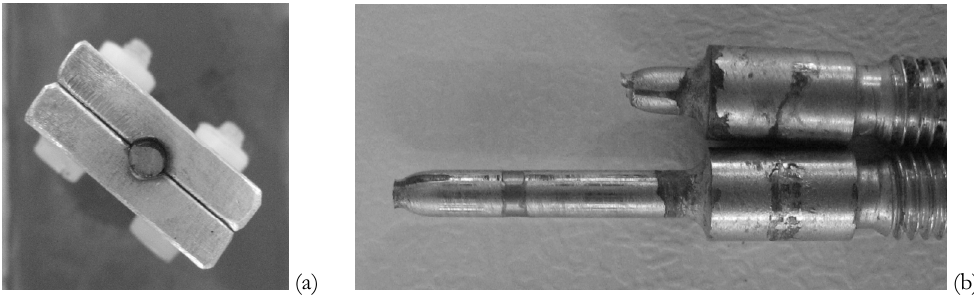
Figure 4: (a) Appearance of AISI 4340 specimen after SSRT coupled to AISI 316 and immersed in NaCl 3,5% aqueous solution and (b) Maraging 250 peak-aged at 480°C